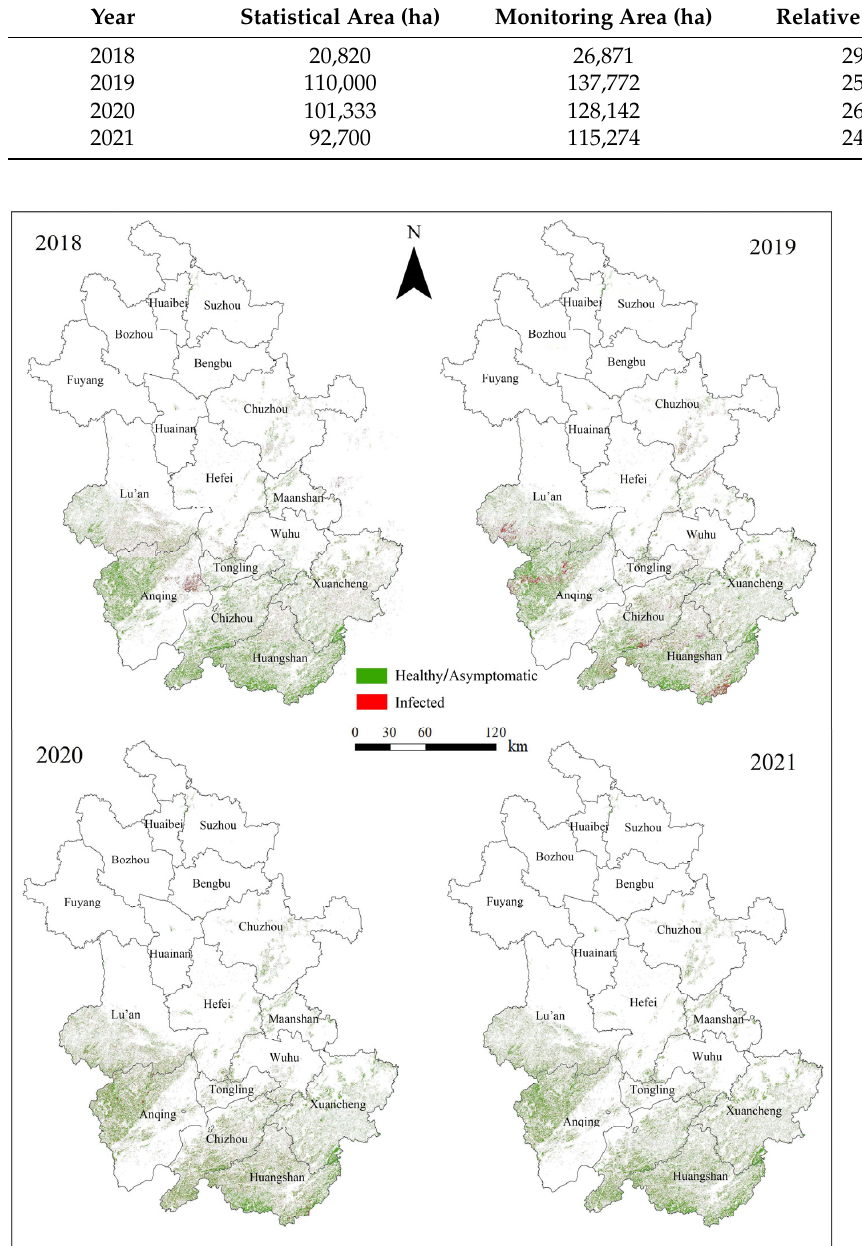
Figure 7. Distribution map of PWD from 2018 to 2021.